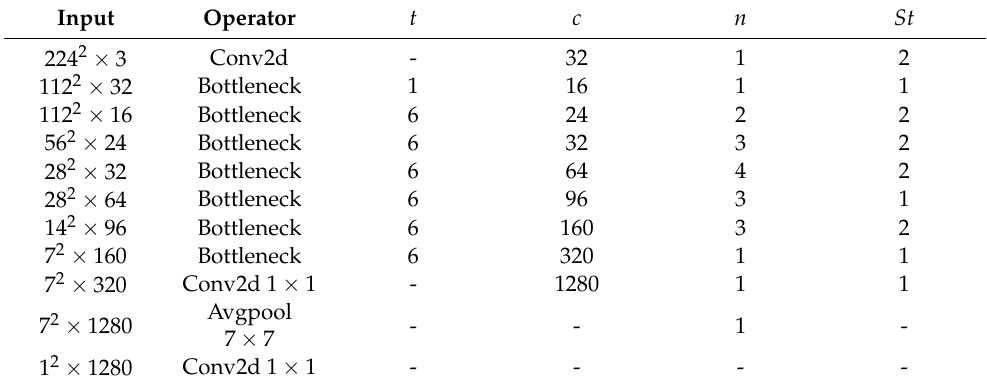
Table 1. MobileNetV2 model structure.